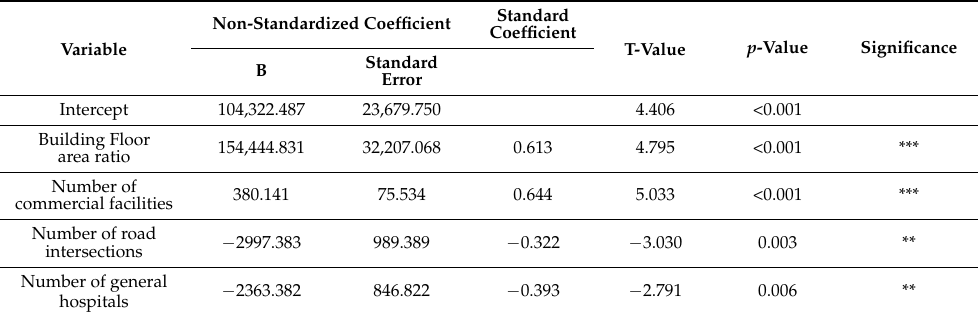
Table 3. Significant variables and regression results affecting the metro ridership of the elderly.